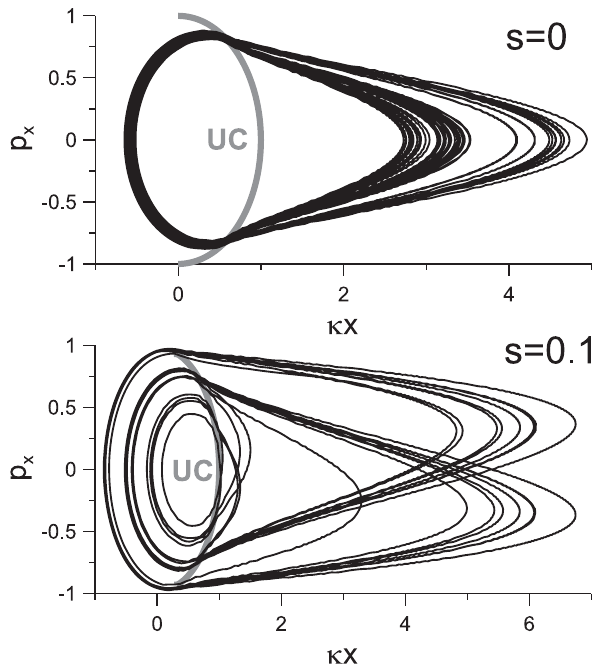
Fig. 6. Schematic view of particles’ trajectories.